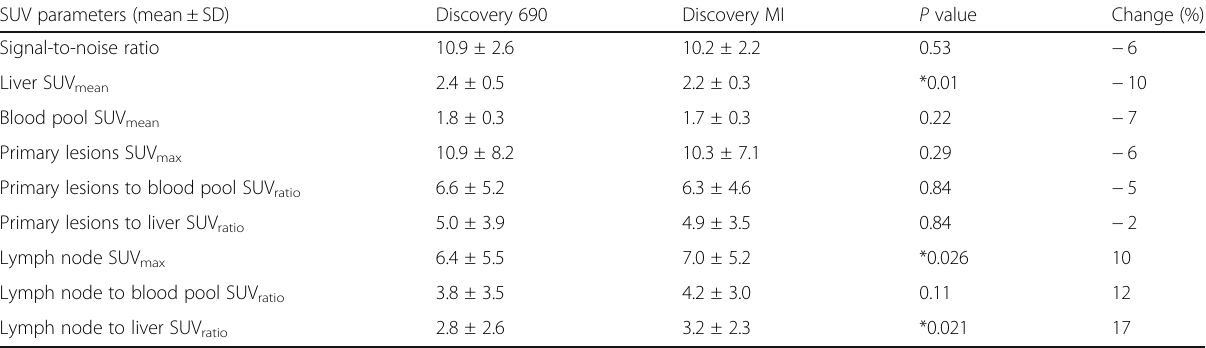
Table 2 Physiological, signal-to-noise ratio, and all lesion SUV parameters SUV parameters (mean±